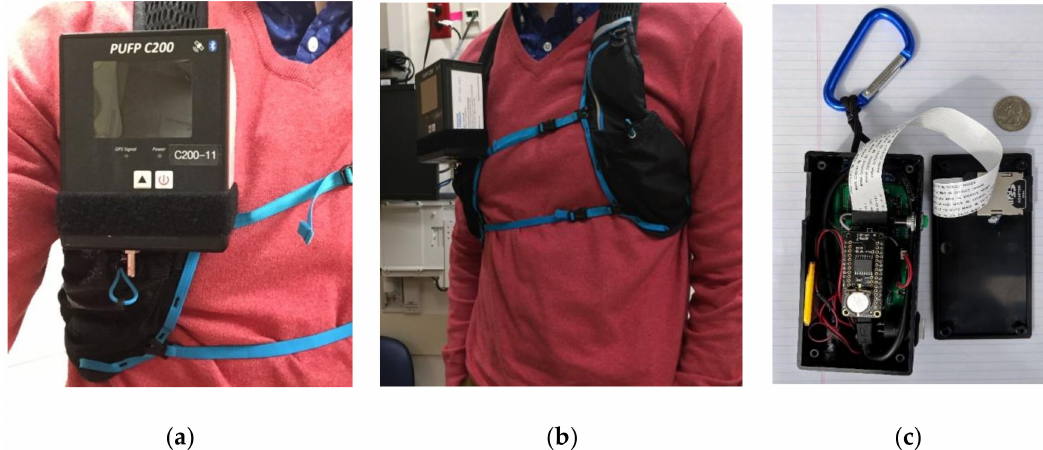
Figure 1. Photographs of PUFP C200 sampler and a NEATVIBEwear personal noise exposure monitor: ( a ) and ( b ) PUFP C200 Personal UFP particle counter worn by participant; ( c ) NEATVIBEwear noise monitor internal components. The dimensions of NEATVIBEwear are 13 × 7 × 4 cm (U.S. quarter shown for scale). NEATVIBEwear is worn by participants in the mesh pocket of the left shoulder strap ( b ). PUFP: Personal